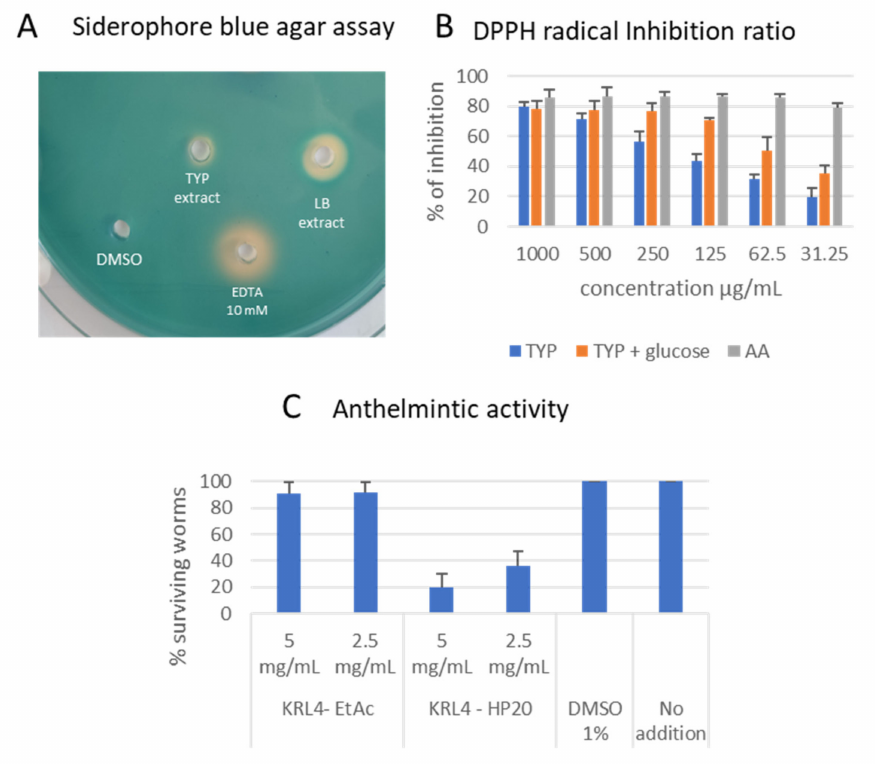
Figure 4. Bioactivity assays. ( A ) Blue agar assays with extracts. ( B ) DPPH radical assay to evaluate antioxidant activities. ( C ) Anthelmintic activity of KRL4 extracts using liquid assay with C.